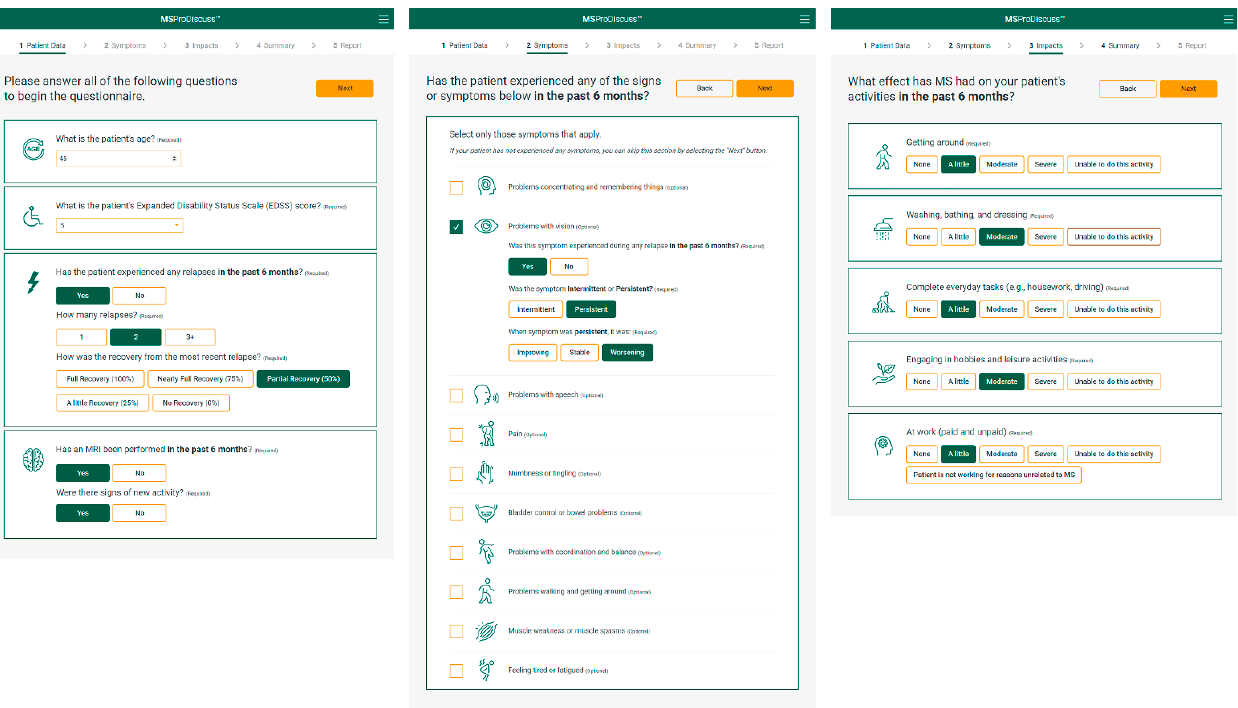
Figure 2. Example of the data input process performed by a physician when using the MSProDiscuss tool. Figure shows a screen shot of the tool that will become available following CE mark certification (see ‘Regulatory Classification’ section for further details) and reproduced with permission from Novartis Pharmaceuticals Corporation. Copyright 2021, Novartis Pharmaceuticals Corporation. MRI, magnetic resonance imaging.